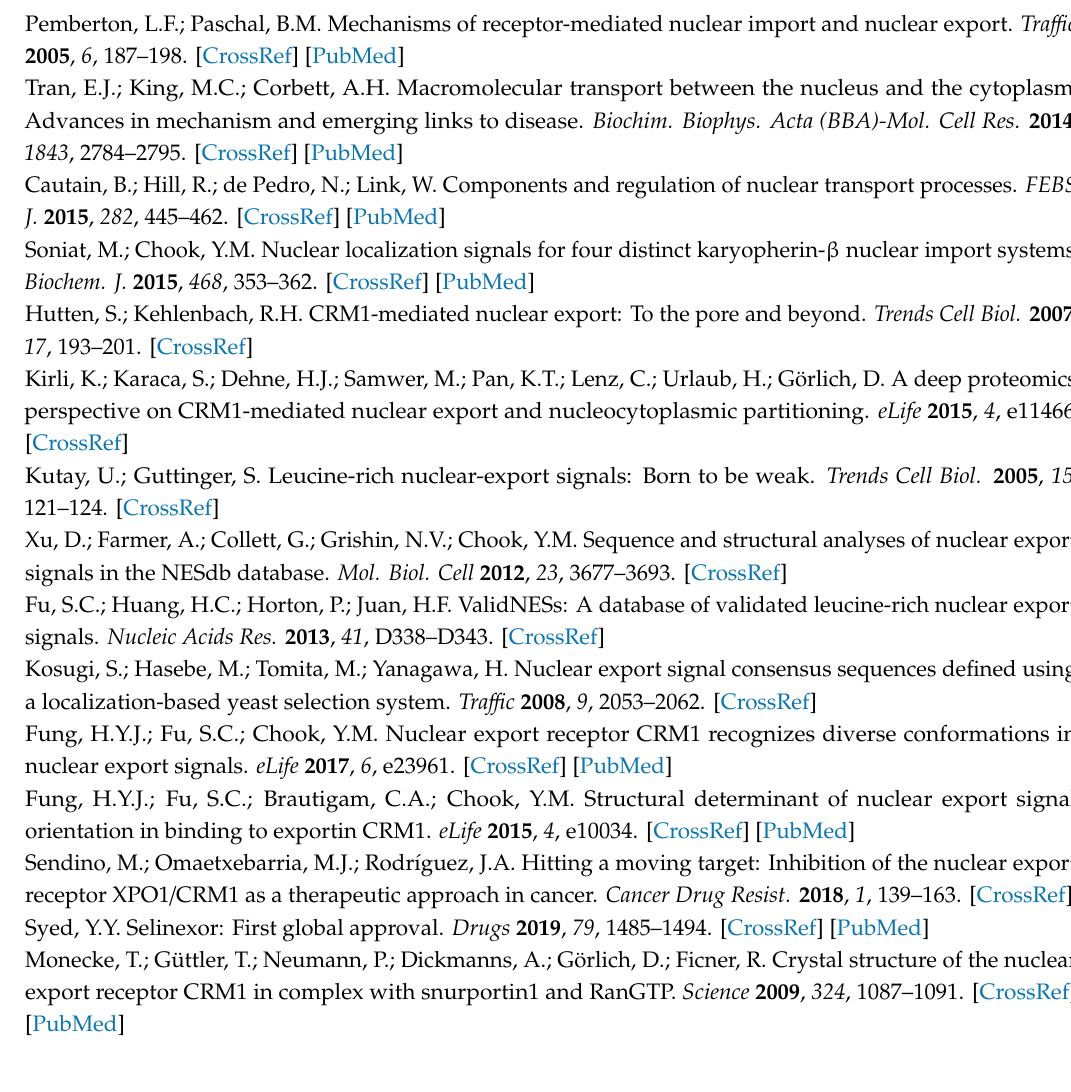
Figure S1. Analysis of candidate NES (cNES) motifs in “XPO1-cancer exportome” proteins using the Rev(1.4)-GFP nuclear export assay. Figure S2. Raw data used to generate the heat map shown in Figure 3C. Figure S3. Nuclear export of MICROP-5 NES motif is blocked by LMB. Table S1. XPO1 / CRM1-cancer exportome proteins